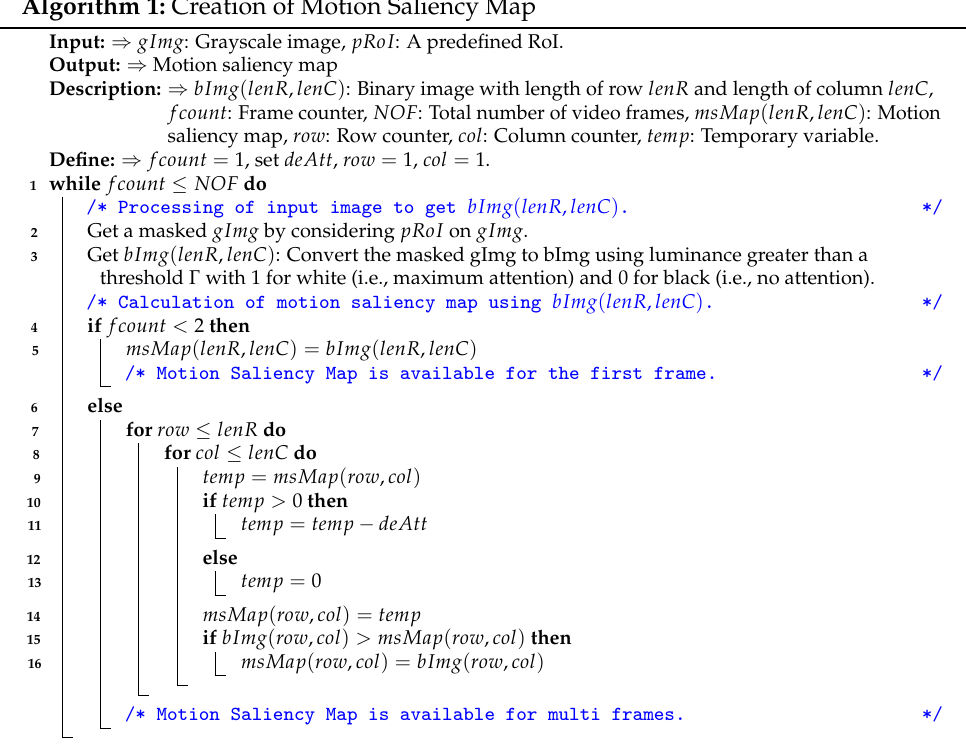
Algorithm 1: Creation of Motion Saliency Map